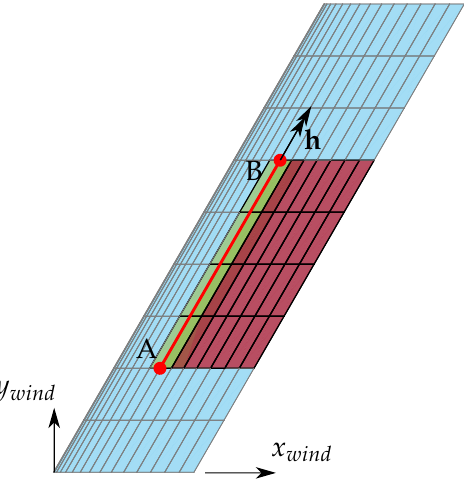
Figure 5. Hinge reference system for a swept wing.